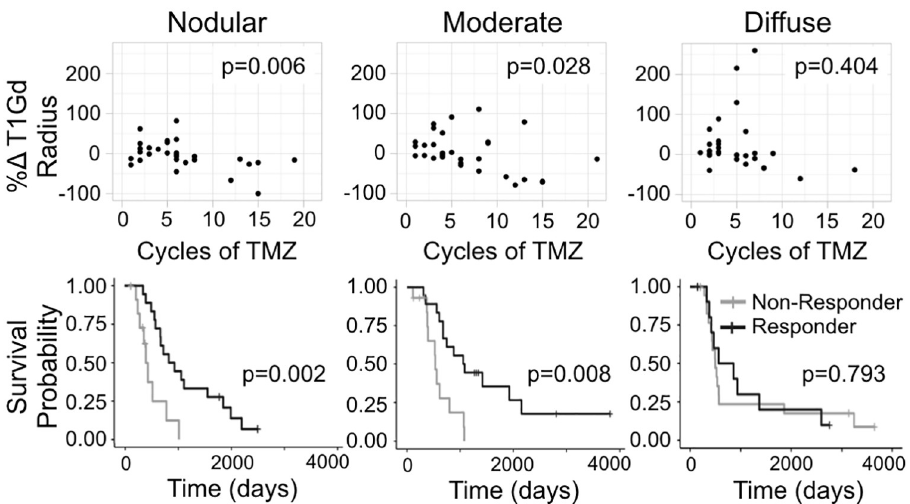
Fig 4. Percent change T1Gd radius vs cycles of TMZ and survival probabilities for responders and non-responders grouped by nodular, moderate, and diffuse tumors. Subjects were split into three evenly sized groups based on their pre-adjuvant D/rho values: lowest third “nodular” (0.0034 to 0.572 mm2), “moderate” (0.6195 to 2.562 mm2), and the highest third “diffuse” (2.567 to 9.53 mm2). Among the nodular tumors (n = 30), there is a significant negative correlation between volumetric response and cycles of TMZ received. Then this improved response is clearly tied to outcome since nodular responders (based on T1Gd volume change) had significantly longer survival than non- responders of the same group. The relationships between cycles, response, and outcome are not significant among diffuse tumors (n = 30).